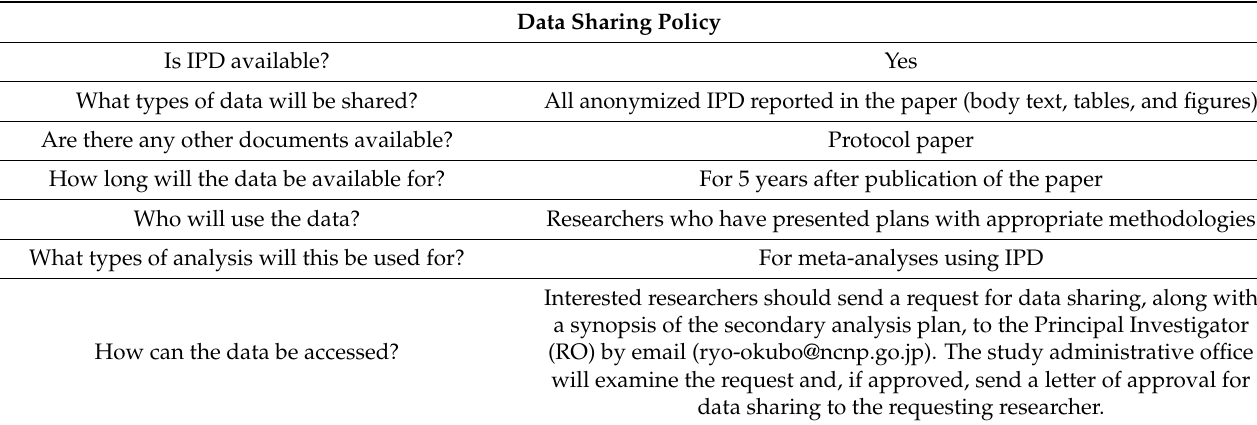
Table 2. Data sharing policy for this study. Abbreviation: IPD, individual participant data. Data Sharing